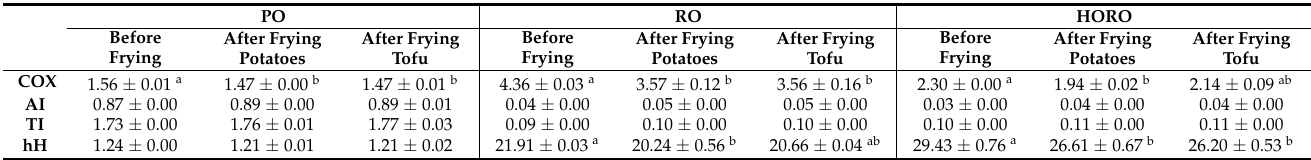
Table 3. Calculated oxidizability value and nutritional quality indexes of tested oils before and after of 18 h deep frying of potatoes or